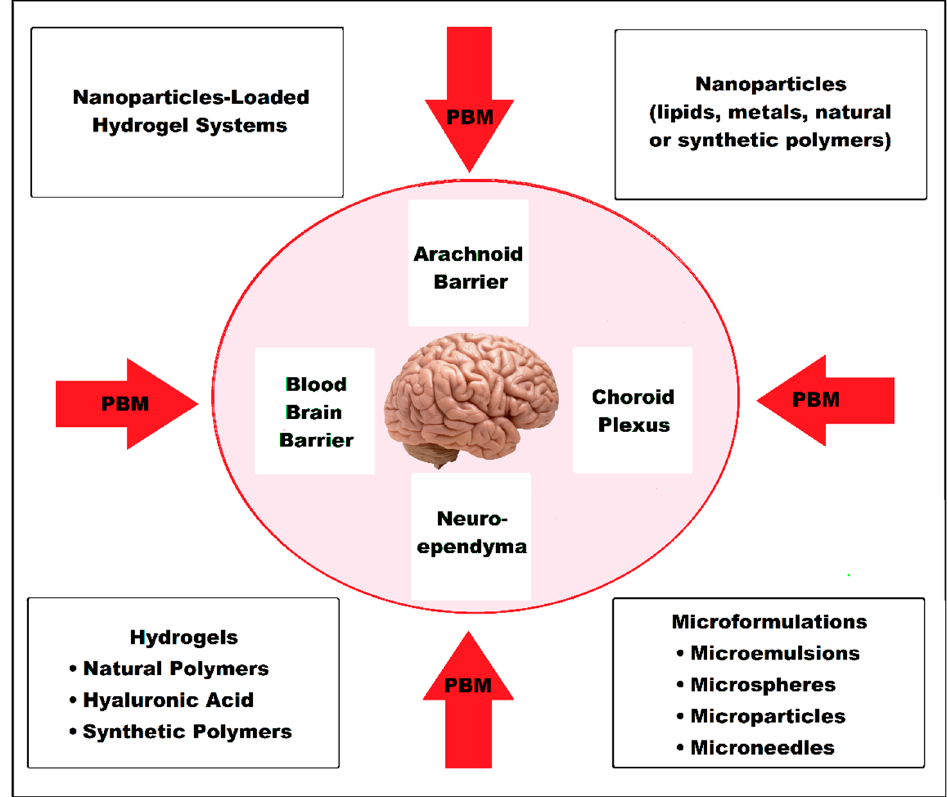
Figure 1. The possible management of AD and dementia to overcome protective brain barriers (arachnoid barrier, blood-brain barrier, choroid plexus and neuroependyma) with nanoscale drug delivery systems and PBM. (Figure 1 was imagined and drawn by L.M.A. using Microsoft Paint 3D for Windows 10 and using completely free picture material (Open—Human Brain Png) from SeekPNG.com (accessed on 31 January 2023), for which we are very grateful).